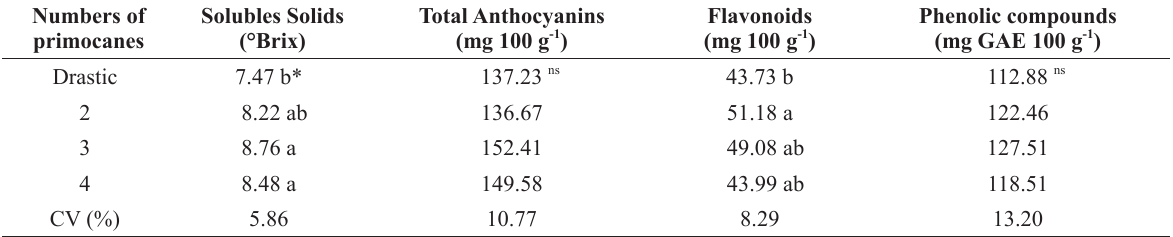
Chemical analysis of solubles solids, total anthocyanins, flavonoids and phenolic compounds for the various numbers of primocanes in blackberry cultivar BRS-Tupy, in Chapecó, SC,